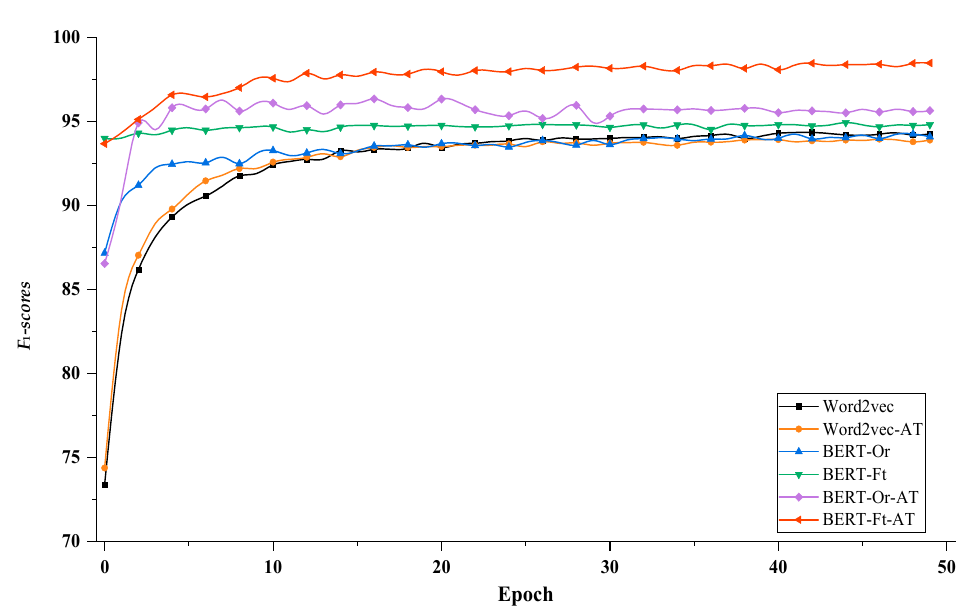
Figure 8. The trend of F 1 for BiLSTM-based models on AgCNER.